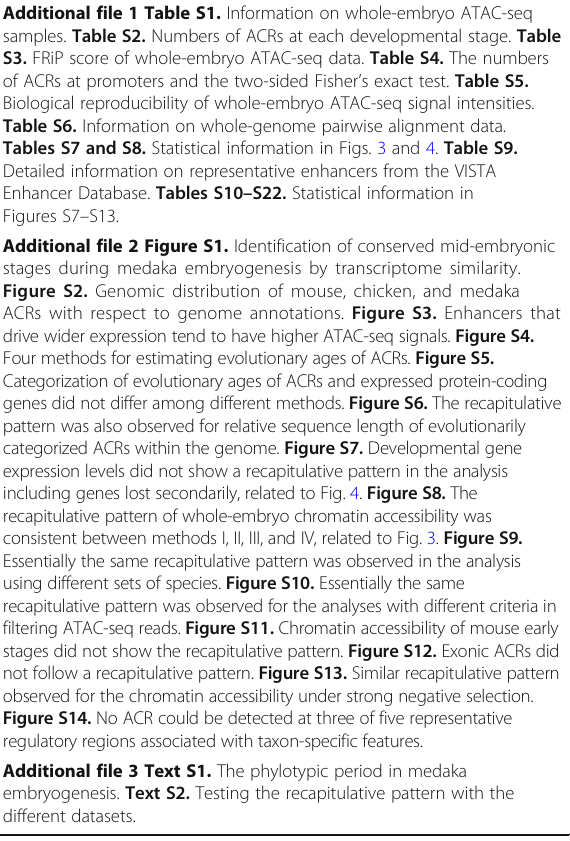
S3. FRiP score of whole-embryo ATAC-seq data. Table S4. The numbers of ACRs at promoters and the two-sided Fisher ’ s exact test. Table S5. Biological reproducibility of whole-embryo ATAC-seq signal intensities. Table S6. Information on whole-genome pairwise alignment data. Tables S7 and S8. Statistical information in Figs. 3 and 4. Table S9. Detailed information on representative enhancers from the VISTA Enhancer Database. Tables S10 – S22. Statistical information in Figures S7 – S13.